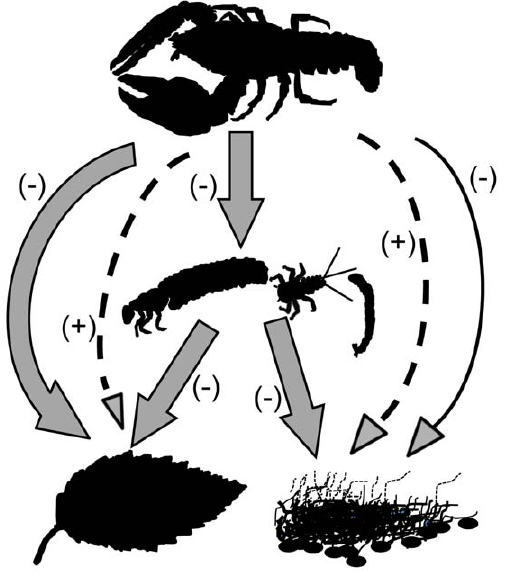
Figure 6. Schemata of the direct and indirect effects of crayfish ( P. leniusculus ). Direct effects are solid arrows, indirect effects are dashed arrows. The direction of the impact is shown in parenthesis.